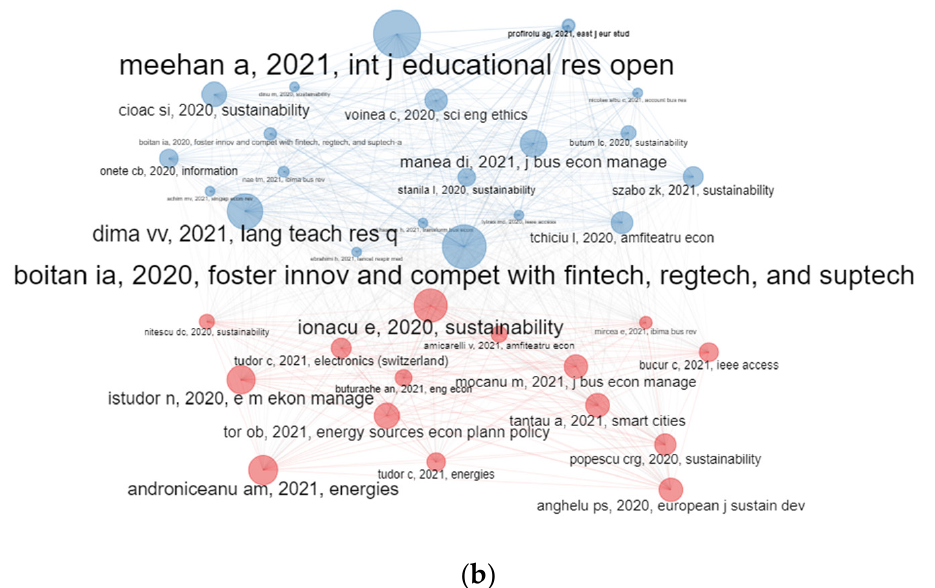
Figure 10. Papers’ clustering by coupling. ( a ) WoS. ( b ) Scopus.